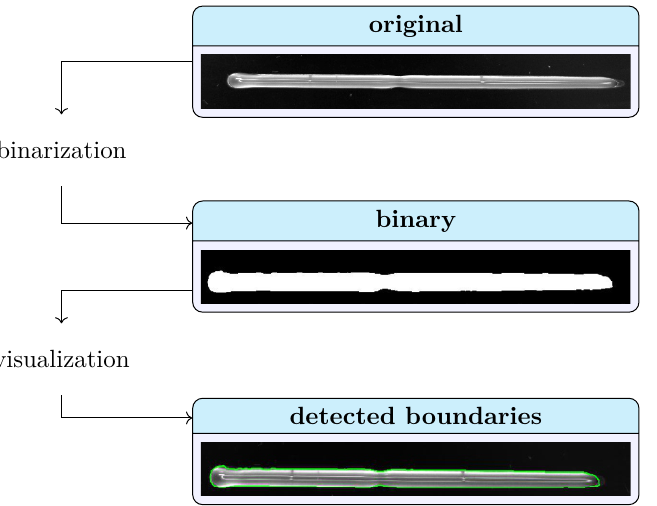
Figure 1. Exemplary representation of the object recognition. The original image ( top ) is binarized using local thresholding algorithms ( middle ), and an overlay with the detected boundaries of the identified structure on the original image was created as a visual control ( bottom